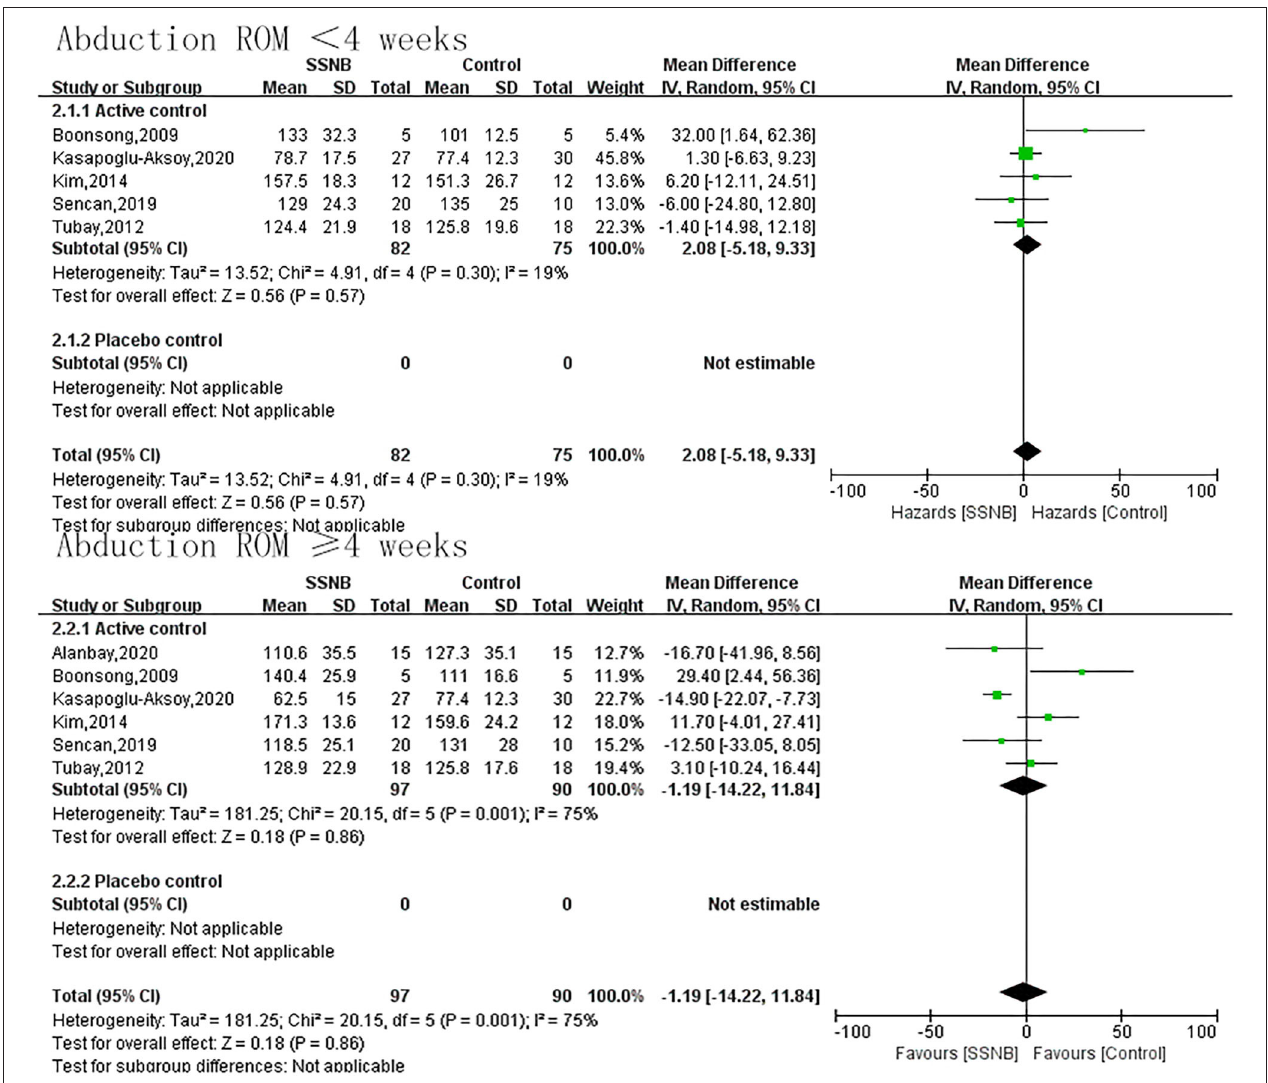
FIGURE 3 | Forest plot of abduction ROM between SSNB and other